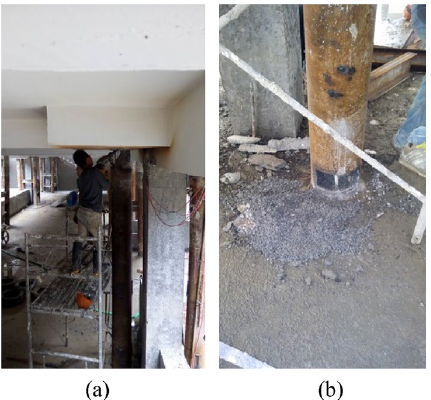
Figure 5. Fine aggregate concrete at the pile top and pile end in the field: ( a ) Pile top; ( b ) Pile